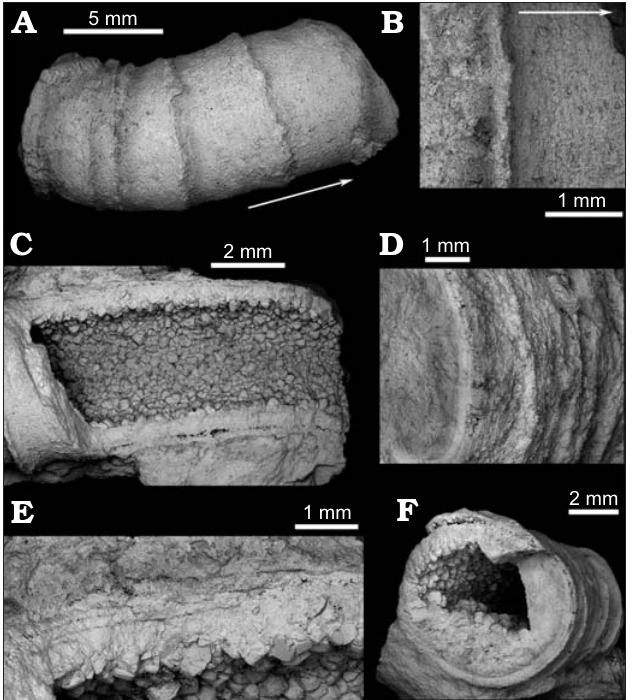
Fig. 3. Serpulid polychaete “ Serpula ” calannai sp. nov. (holotype MSNC 4549-33) from the Wordian to upper Permian, “Pietra di Salomone” Lime- stone, Sicily, Italy. A . Tube fragment before assembling. Growth direction, inferred from the slightly flaring peristomes, marked by an arrow. B . Detail of a peristome and growth lines. C . Longitudinal fracture of tube displaying wall section and inner surface covered by secondary crystals. D . Oblique view of tube showing prominence of ornamentations. E . Detail of C show- ing layered structure of tube wall, only locally preserved. F . Circular cross section of tube, with relatively thick wall locally showing its likely original layering. All SEM images.